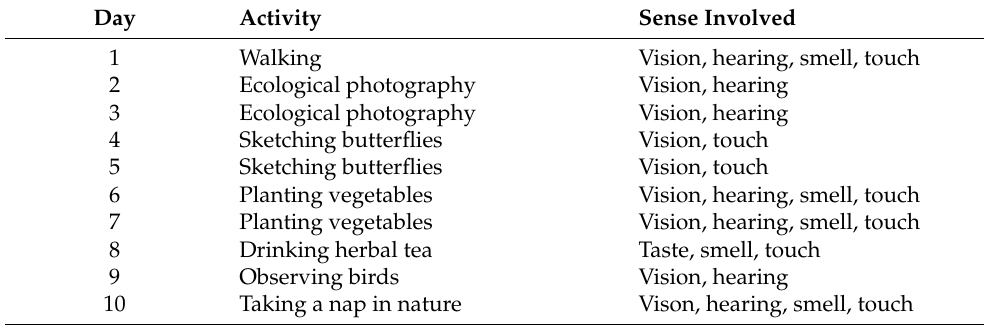
Table A1. Description of the Activities for Each Sense.